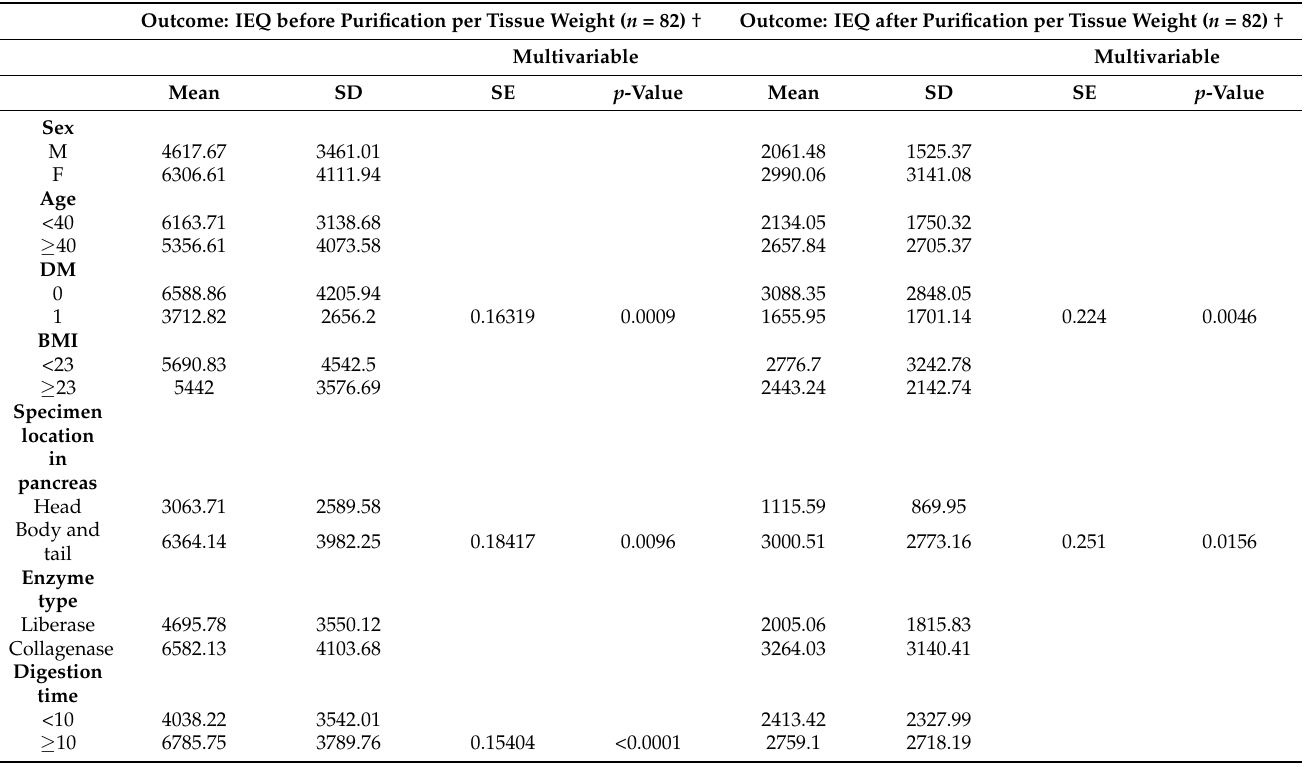
Table 2. Multivariate analysis of factors affecting pancreas islet isolation